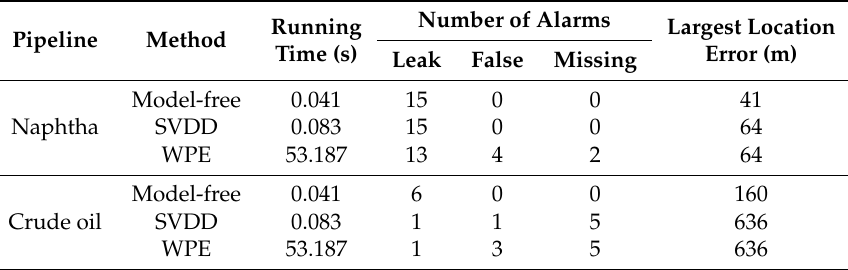
Table 4. Comparison of offline test between the model-free-based (proposed), support vector domain description (SVDD)-based and WPE-based methods on the naphtha